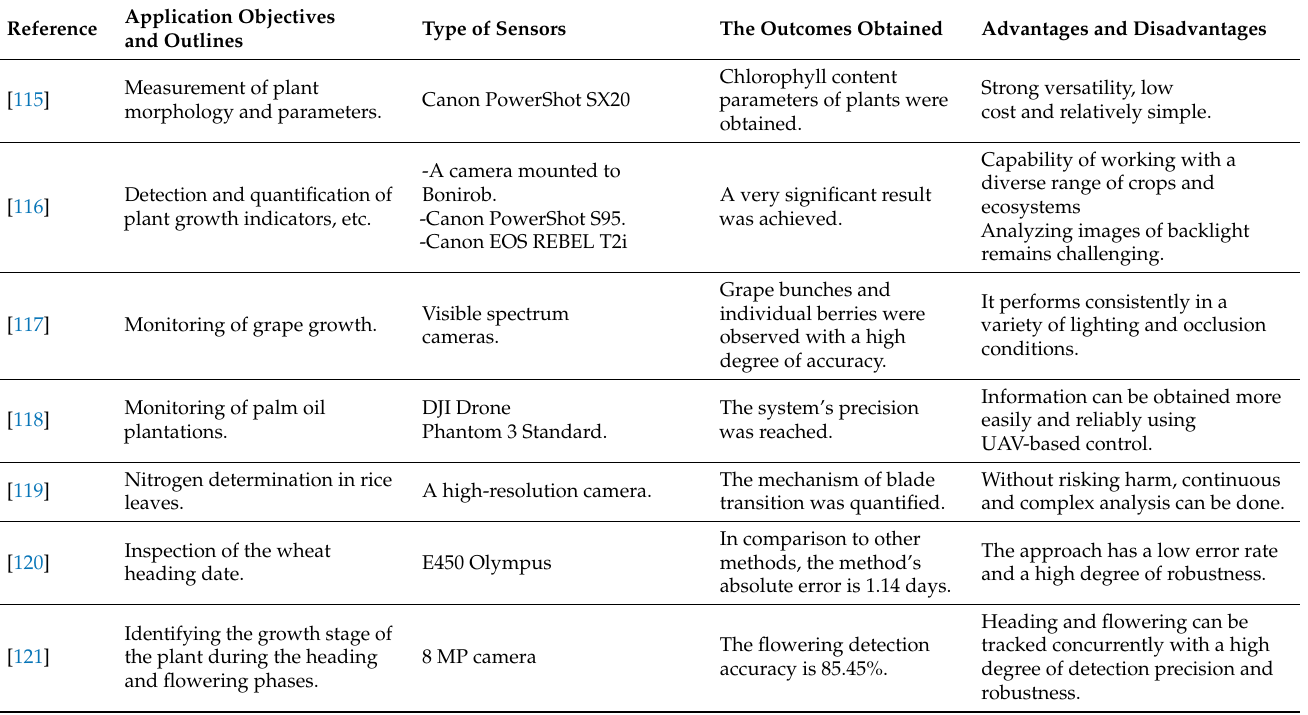
Table 2. Review of methods and sensors used to monitor crop